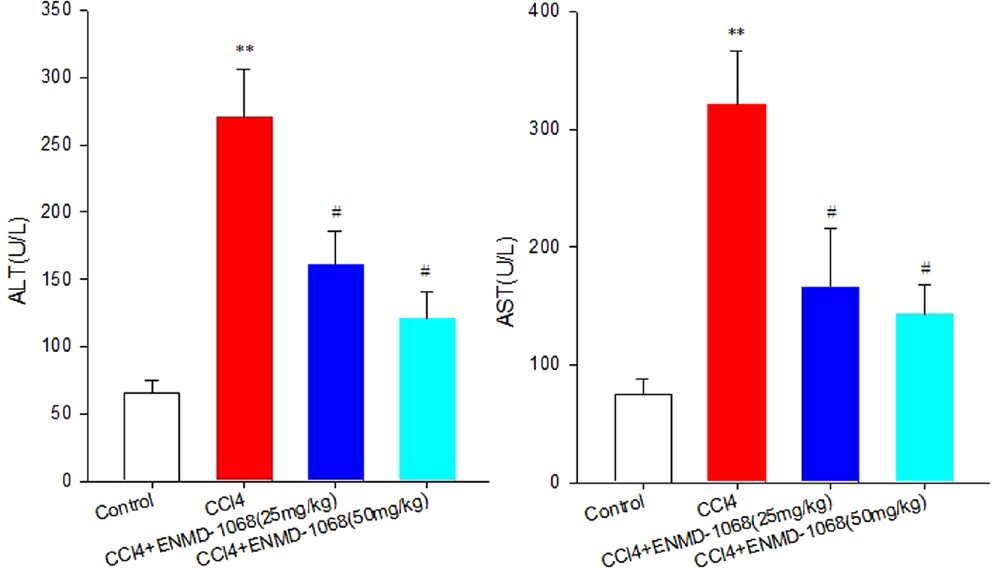
Figure 2. Effect of ENMD-1068 on ALT and AST levels. Control mice were treated with olive oil. Mice in CCl 4 group received intraperitoneal injections of CCl 4 twice per week. 25 mg/kg or 50 mg/kg ENMD-1068 were administered intraperitoneally 15 mins before CCl 4 treatment twice per week for 4 weeks. All animals were sacrificed at 4 weeks after CCl 4 treatment and serum was collected for ALT/AST test. Relative to control, ENMD-1068 treatment at both 25 and 50 mg/kg reduced ALT and AST levels. N = 6, bars represent SD, ** P < 0.01vs Control, # P < 0.05 vs CCl 4